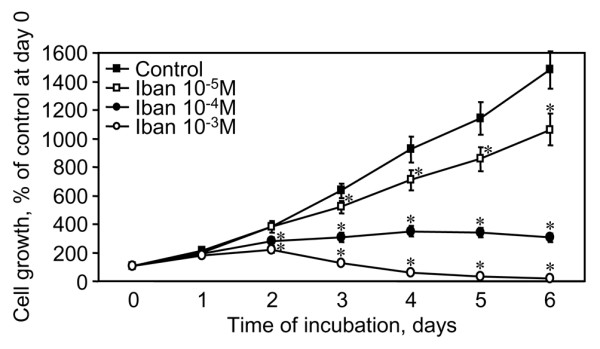
Time-course experiments of ibandronate (Iban) on MCF-7 cells. Cells were cultured for up to six days in steroid-free medium containing Iban or vehicle (control). Cell growth was determined as described in Fig. 1. Statistical analysis on log transformed data; asterisks indicate ANOVA p < 0.01 versus control at the same day, Dunnett post hoc test.